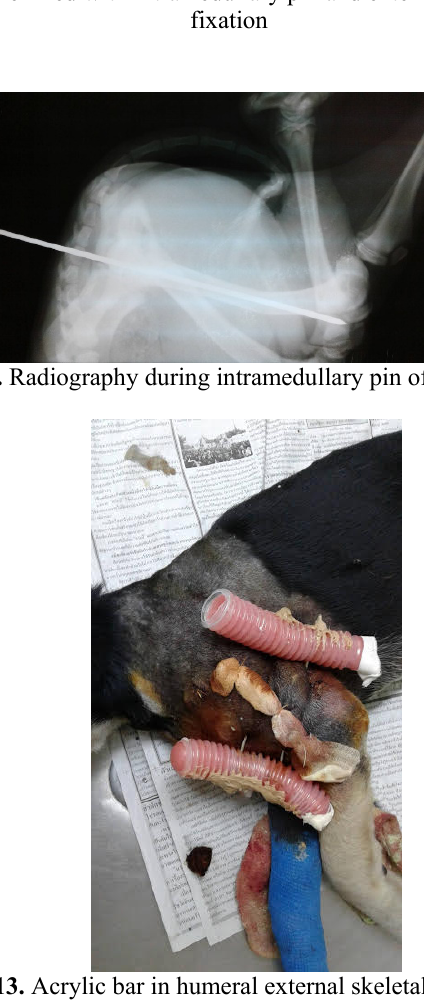
Fig. 11. Radiography in young dog showed both humerus